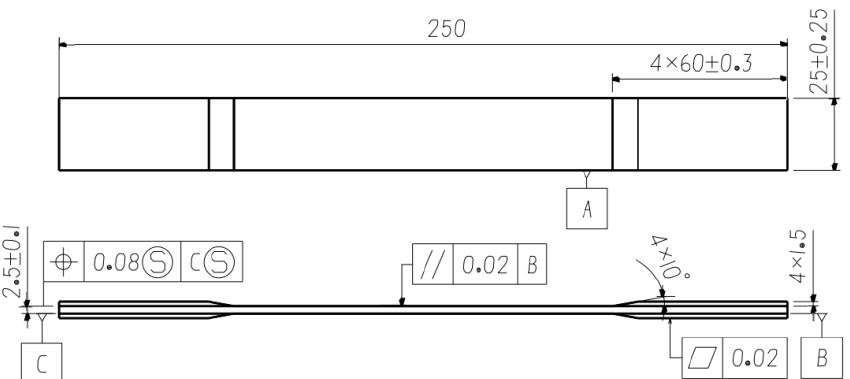
Figure 1. Static and tensile fatigue specimens. Table 1. Test types and specimen